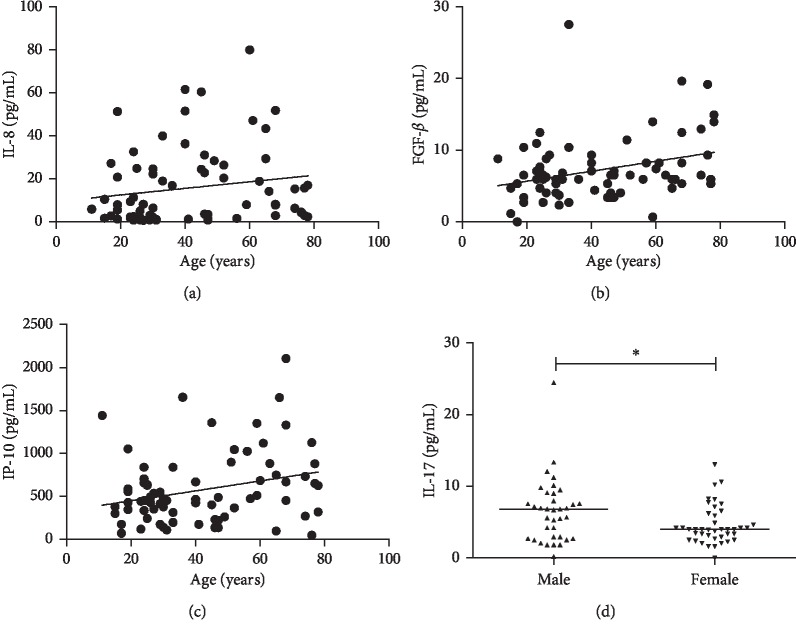
Correlation between cytokine concentration and age/gender. The 77 samples included samples from 36 males and 41 females, ranging in age from 11 to 78 years with a median age of 36 years.